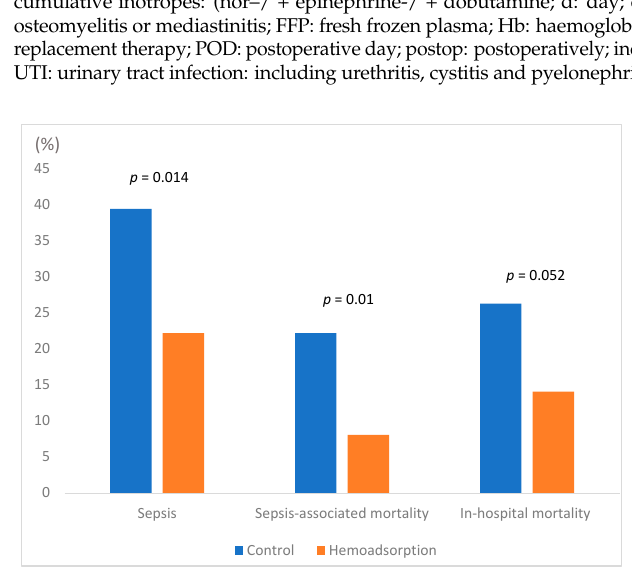
Figure 1. Sepsis, sepsis-associated mortality, and in-hospital mortality (propensity-matched co- hort).